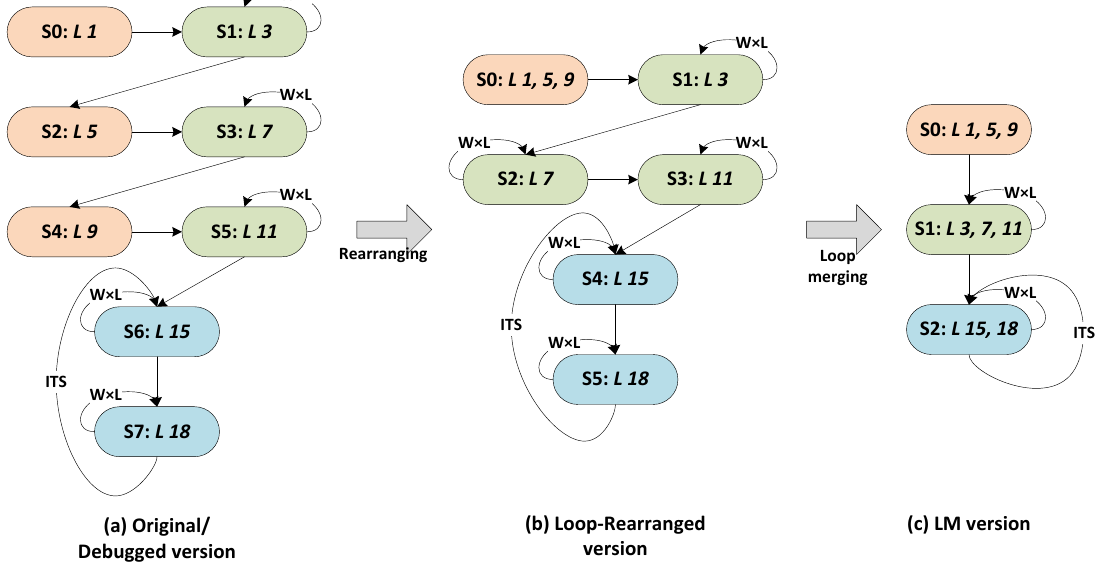
Figure 4. Finite State Machine (FSM) transition within Loop Manipulation: “ L * ” refers to the operations covered in the present state, in which “ * ” indicates the line number in Algorithm 1, W × L = 948 × 450 is the image dimension and ITS is the maximum iteration number defined as five in this